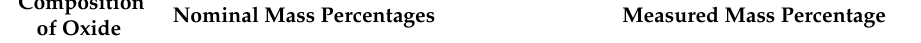
Table 2. Mass percentages m% of the synthesized mixed oxides determined by X-ray fluorescence (XRF) analysis. Shown are the averaged values of three repeated measurements of one sample at di ff erent areas with standard deviations.